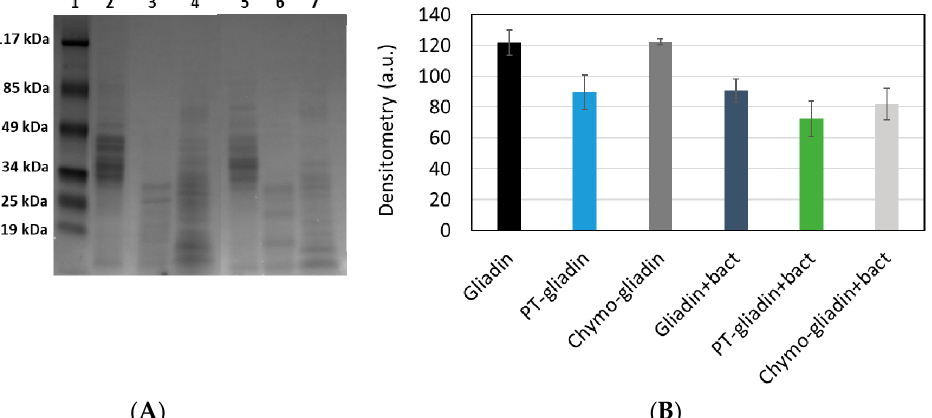
Figure 1. ( A ) Sodium dodecyl sulfate polyacrylamide gel electrophoresis (SDS-PAGE) analysis of gliadins. (1) Molecular weight (MW) markers; (2) Gliadin standard; (3) PT-gliadin; (4) Chymo-gliadin; (5) Gliadin + bact; (6) PT-gliadin + bact; (7) Chymo-gliadin + bact. ( B ) Densitometry of the lanes from about 55 kDa to the bottom of the lane performed by using ImageJ software.